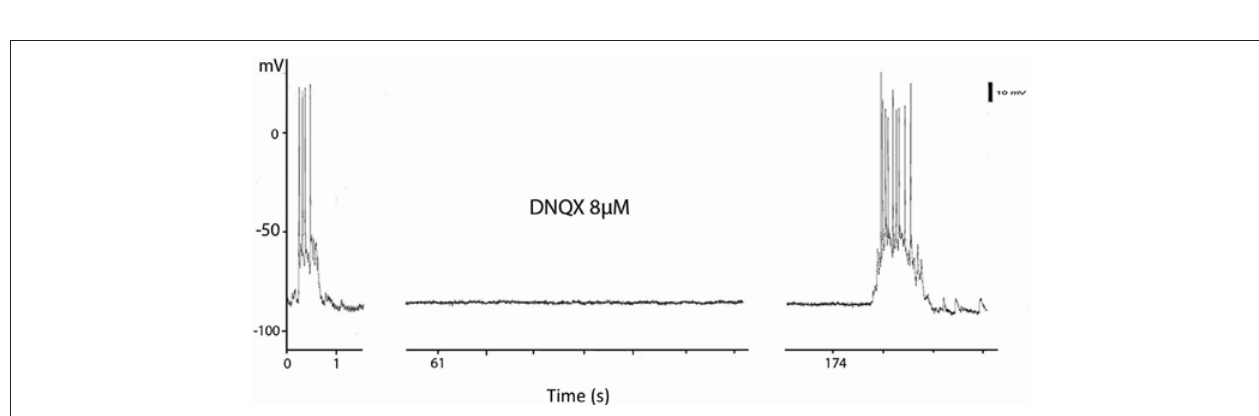
Figure 5 | Details of uP states. Current clamp recordings of a striatal neuron in a mixed culture. The upper record on a slower timescale shows the rate of the bursts, while the final burst on the record is shown at a faster timescale below.